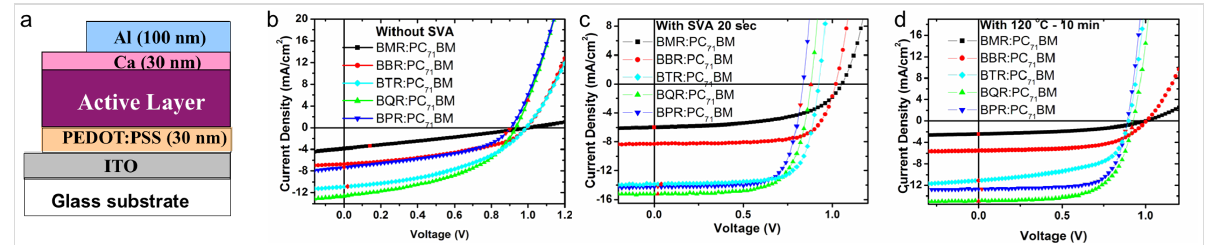
Figure 12: J–V characteristics of BXR : PC 71 BM BHJ solar cells. (a) device structure, (b) J–V curves for as-cast, (c) J–V curves for SVA with THF, (d) and J–V curves for TA at 120 °C for 10 min.